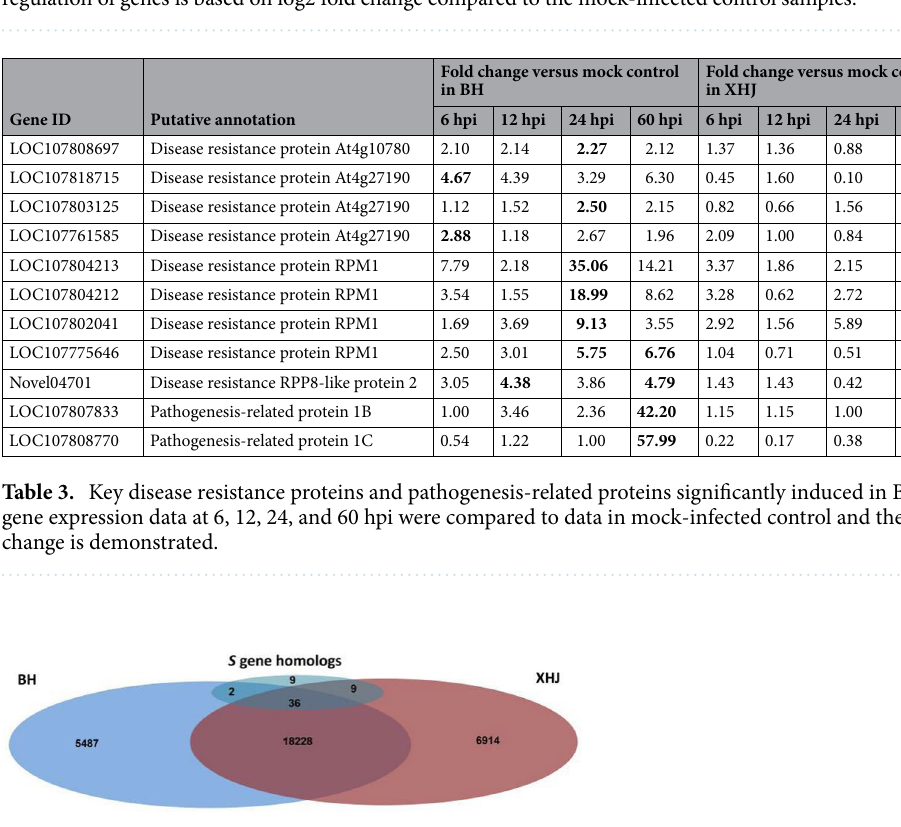
Figure 6. Venn diagram of DEG identified in the BH group, XHJ group and S gene